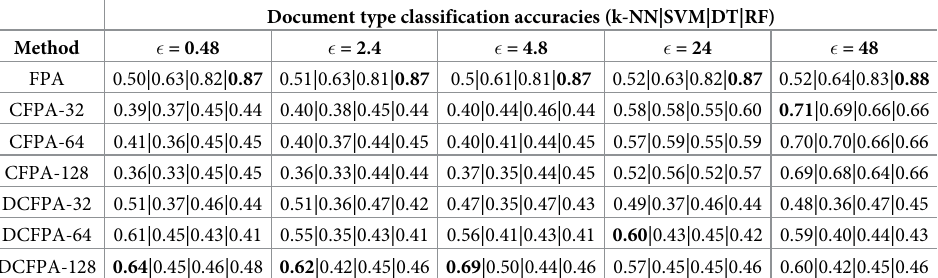
Table 1. Document type classification accuracies in the MPIIDPEye dataset using differentially private eye move- ment features with majority